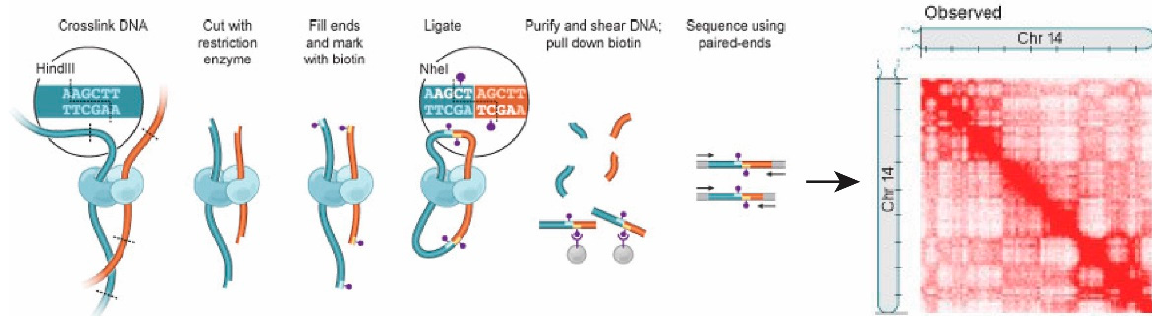
Figure 4. Overview of the Hi-C experiment. Crosslinking of cells with formaldehyde results in covalent attachment of DNA-binding proteins bound to spatially adjacent genomic regions. Chromatin is cleaved with a restriction enzyme (e.g., HindIII, and the single-stranded overhangs created are filled with biotinylated nucleotides (purple dots). The ends of DNA are ligated at low concentrations for intramolecular ligation. DNA is purified and sheared, and streptavidin beads are used to isolate DNA fragments containing biotin label. The interacting genomic DNA regions are identified by paired-end sequencing. Heatmap corresponding to intrachromosomal interactions on chromosome 14 is shown. These figures are adapted from van Berkum et al. [56].